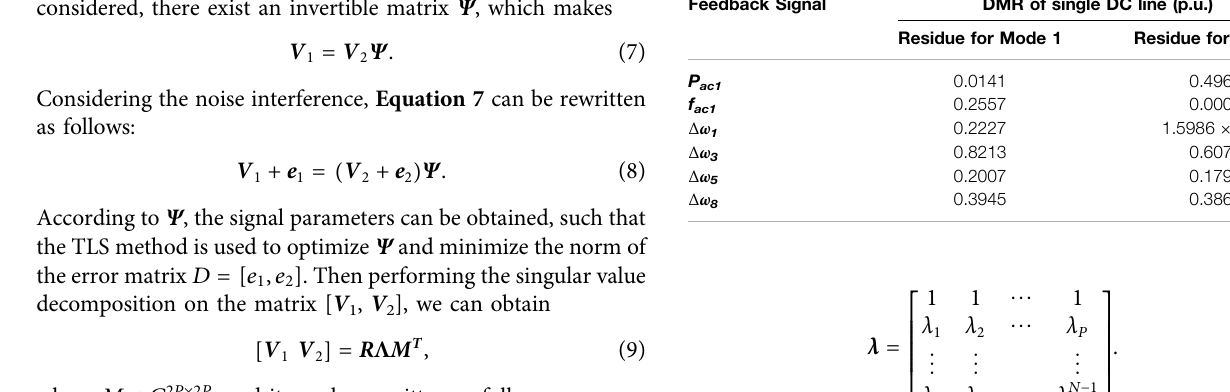
TABLE 1 | Residues of different signals. Feedback Signal DMR of single DC line